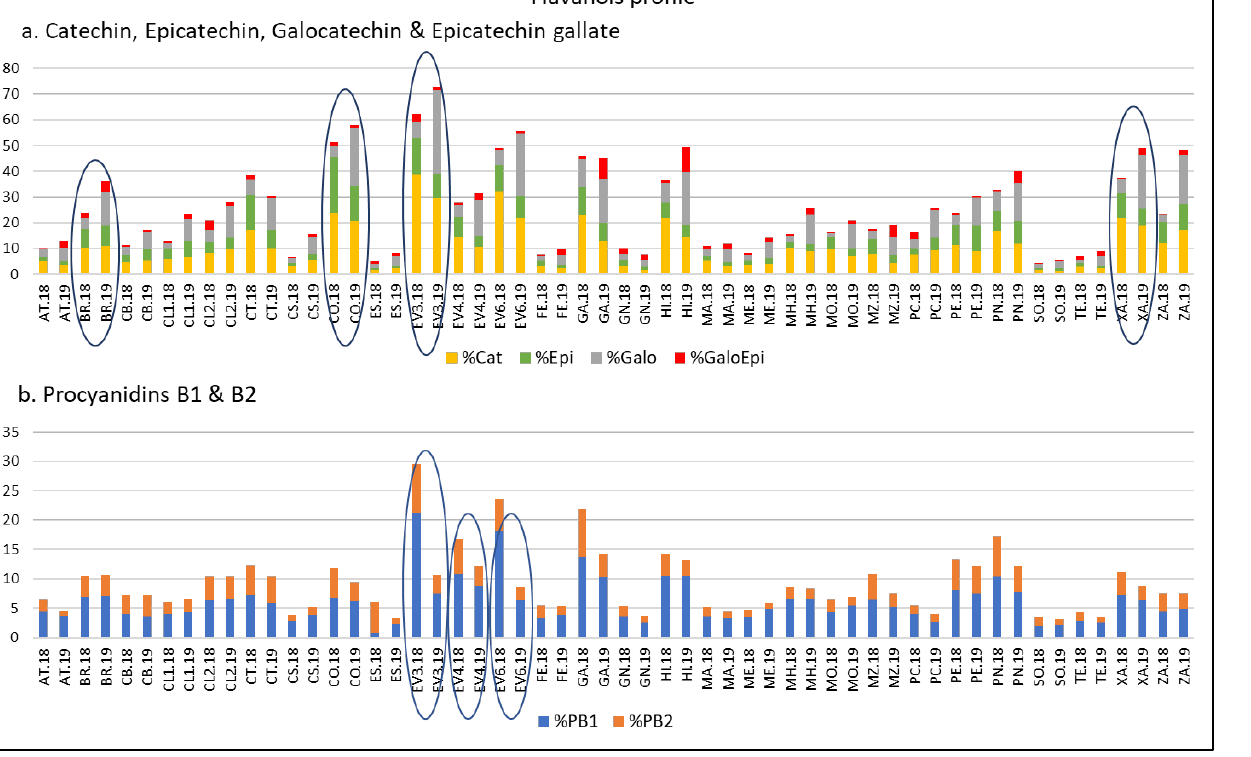
Figure 3. Flavanols profile of varieties from the EVEGA germplasm bank in 2018 and 2019 vintages. % Cat, % Galo, % Epi, % GaloEpi, % PB1, and % PB2 refer to percentage of catechin, gallocatechin, epicatechin, epicatechin gallate, procyanidin B1, and procyanidin B2, respectively, with respect to TPC values. See Table 1 for varieties abbreviations.